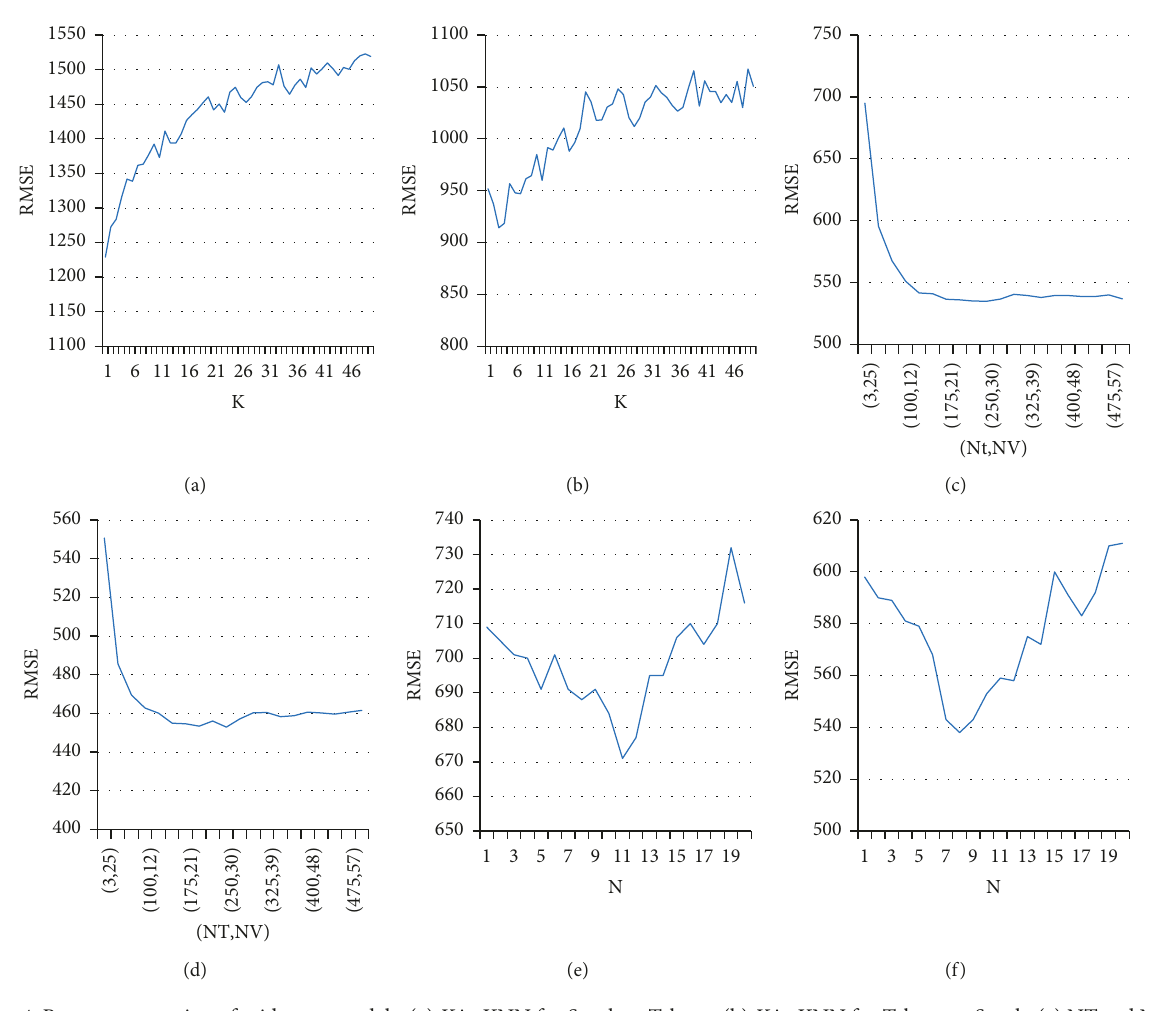
Figure 4: Parameter tunning of mid-term models. (a) K in KNN for Saveh to Tehran. (b) K in KNN for Tehran to Saveh. (c) NTand NV in RF for Saveh to Tehran. (d) NT and NV in RF for Tehran to Saveh. (e) N in RNN for Saveh to Tehran. (f) N in RNN for Tehran to Saveh.